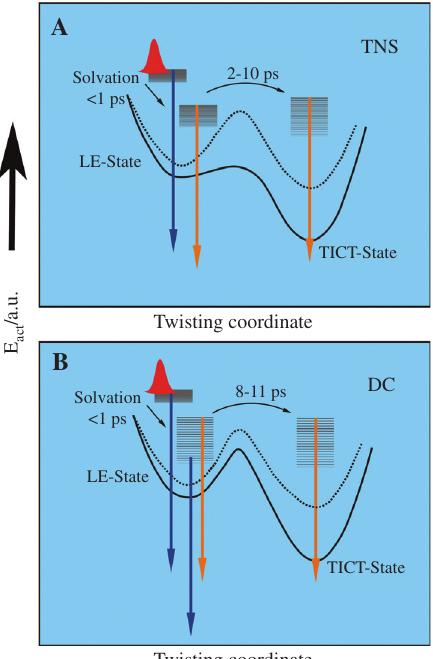
Figure 6 Schematic potential energy curves along the reaction coordinate (twisting) for the two probes (A) TNS and (B) DC with the observed